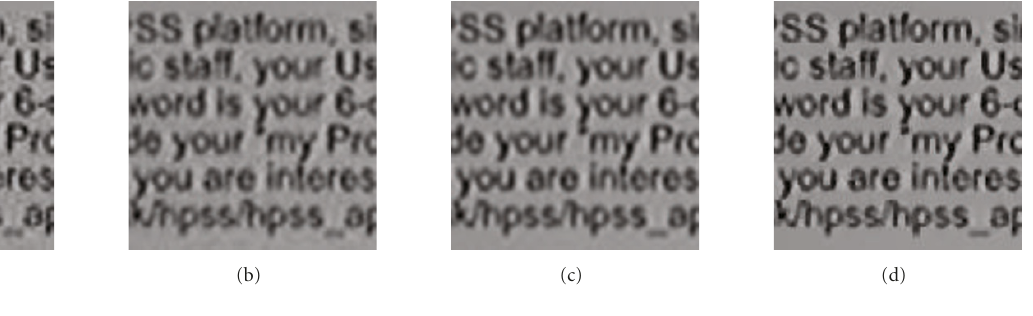
Figure 18: (a)–(d) Detail regions cropped from Figures